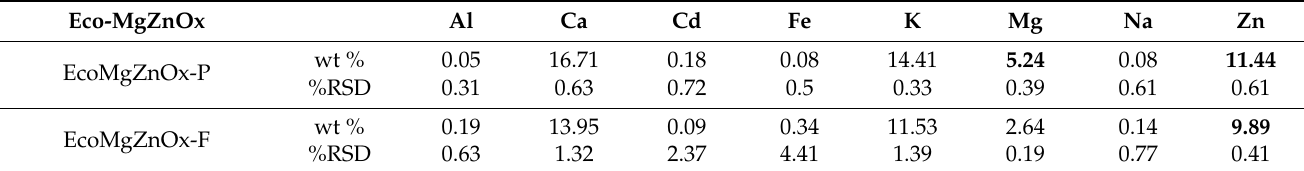
Table 1. Mineral composition of Eco-MgZnOx catalysts determined by MP–AES analyses (wt %) with relative standard deviation percentage ( ± % RSD,